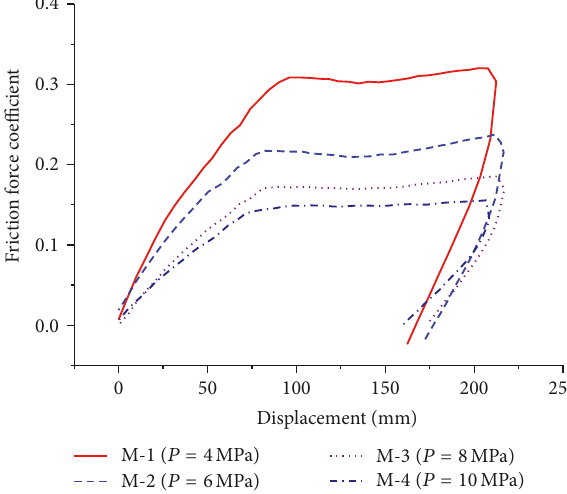
Figure 15: Relationship of friction force coefficient and displace-